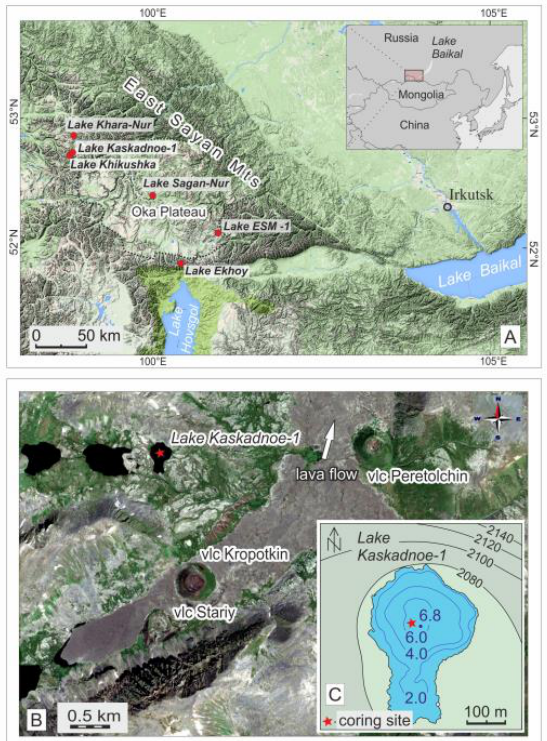
Figure 1. ( A ) Map based on Shuttle Radar Topography Mission (SRTM) v4.1 data [23], showing the position of the study area in the south of the Baikal region (upper right inset), and the position of Kaskadnoe-1 Lake on the Oka Plateau. Other red dots correspond to the previously studied sections of lake sediments of the Late Glacial–Holocene age in the East Sayan Mountains. ( B ) Position of Lake Kaskadnoe-1 near volcanic centers of Late Pleistocene-Holocene eruptions. The white arrow shows the direction of lava flows. ( C ) Bathymetric map with the coring site location. Numbers from 2080 to 2140 refer to elevations in meters above sea level. The contours of the Oka plateau are shown by a dotted line.